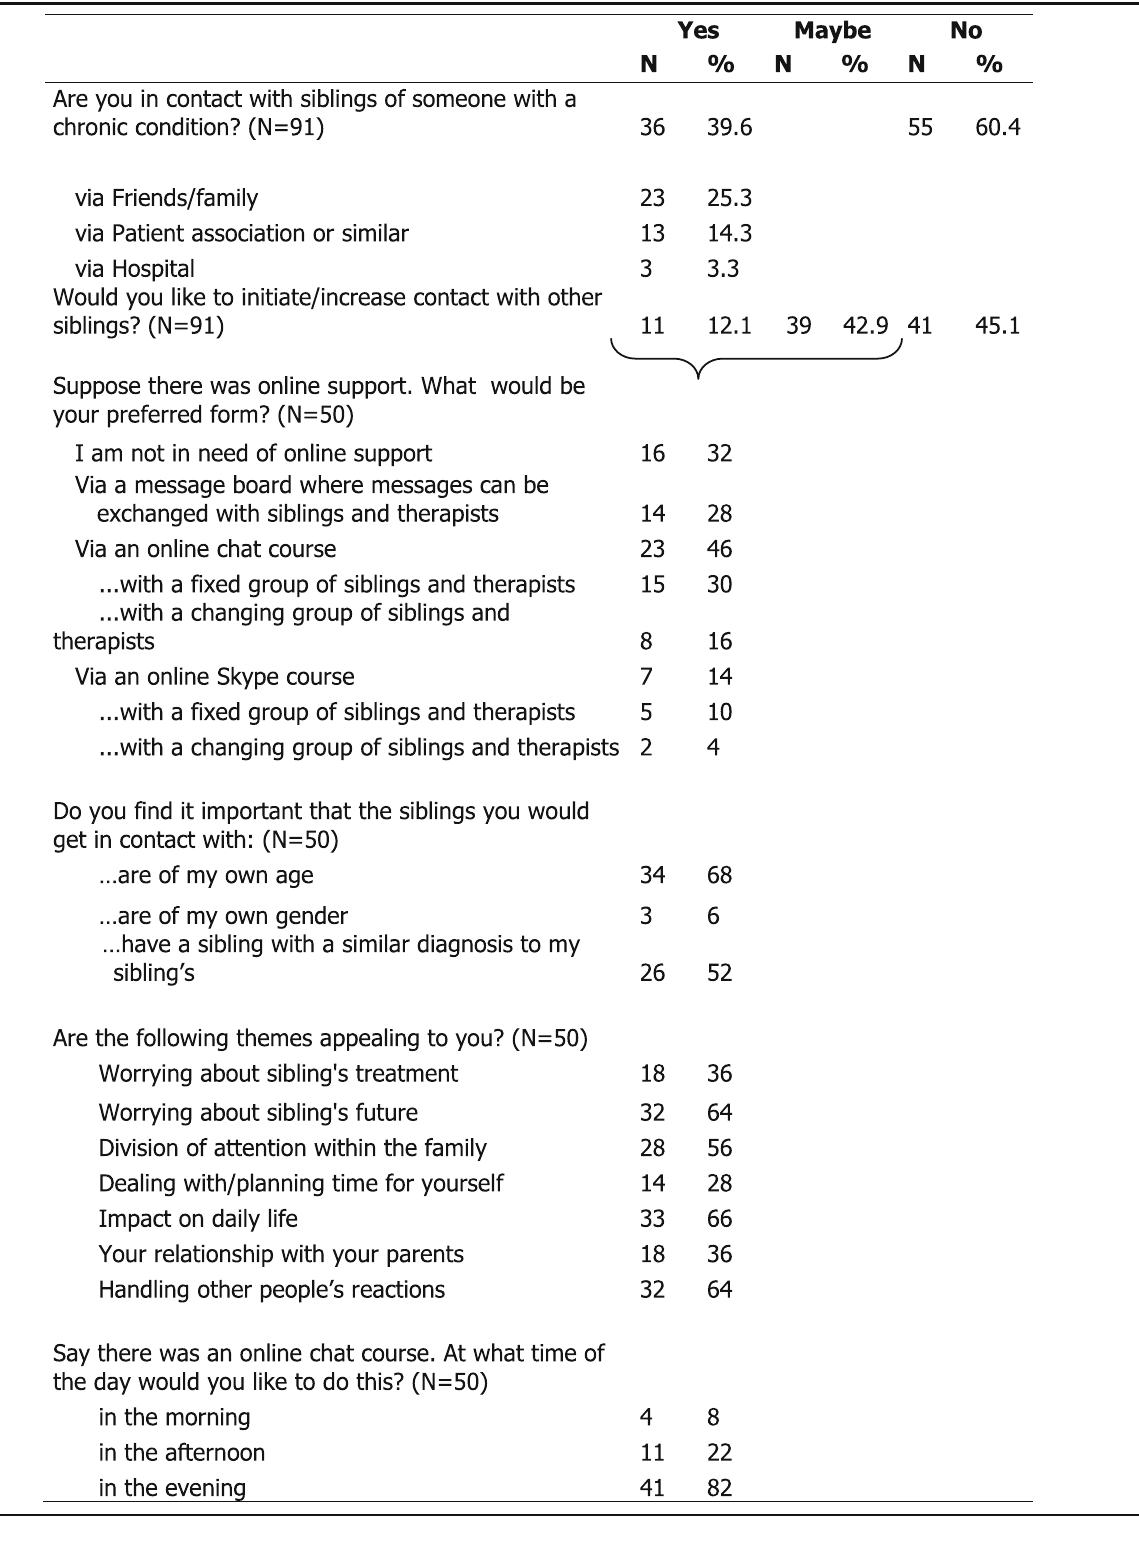
Table 2 Results of multiple-choice questions about online support needs and themes for online